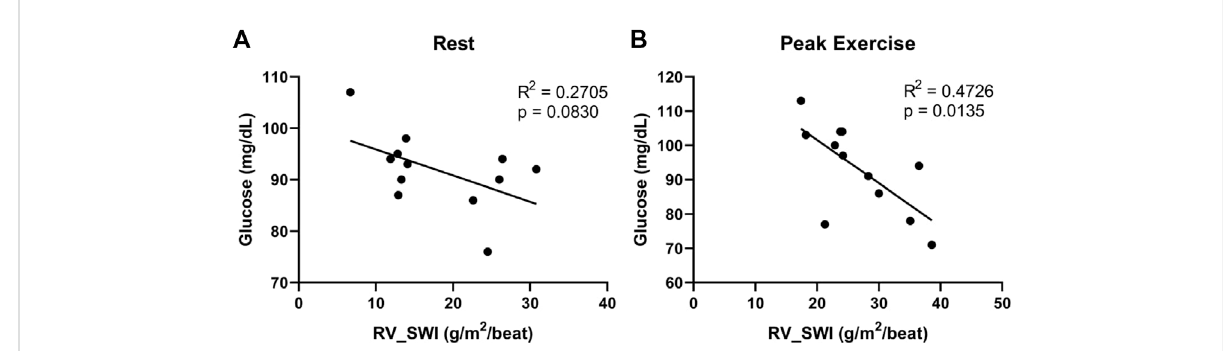
FIGURE 2 Correlations between right ventricular stroke work index (RV_SWI) and pulmonary artery glucose levels, measured at rest (A) and peak exercise (B) in 12 patients with systemic sclerosis-associated pulmonary arterial hypertension.